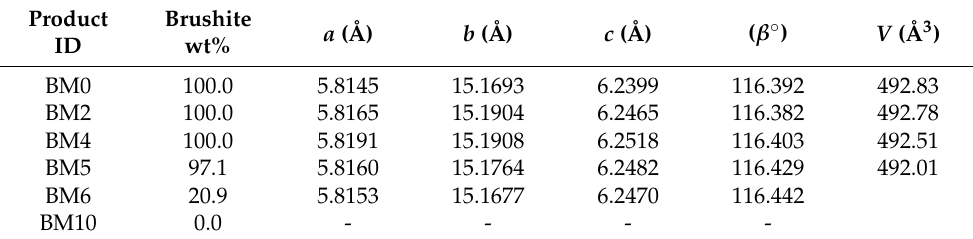
Table 2. Refined unit cell parameters for brushite from XRD data using the Rietveld approach *.